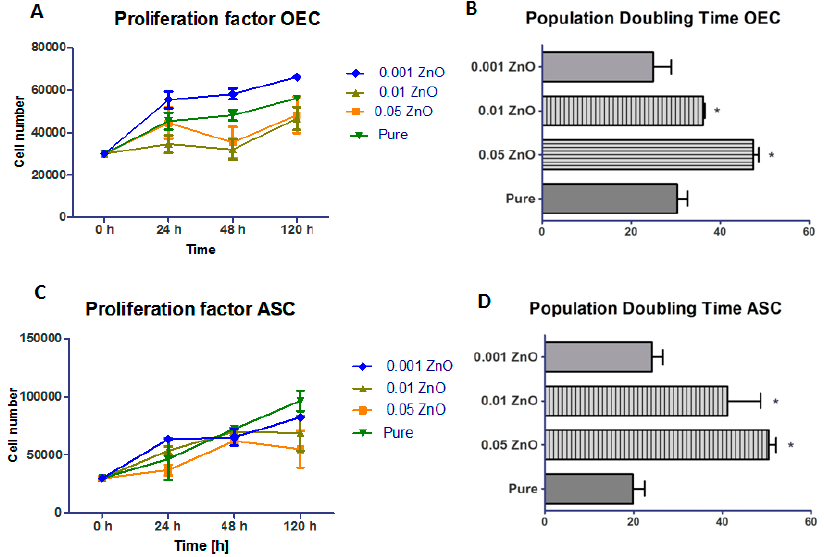
Figure 3. Growth curves ( A , C ) and the population doubling times ( B , D ) of olfactory ensheathing cells ( A , B ) and adipose stem cells ( C , D ) during 120 h of experimental culture on different polymers; * p < 0.05.